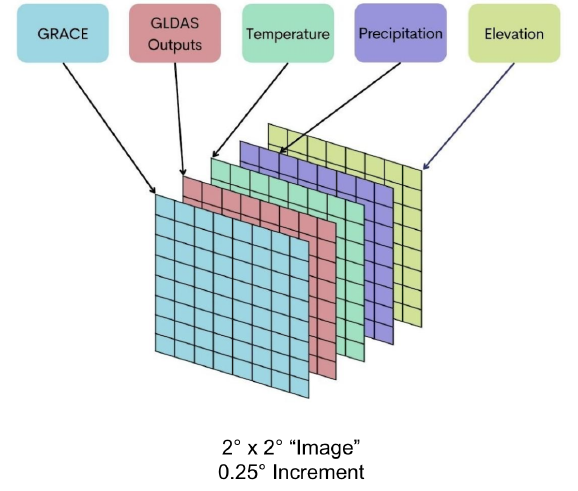
Figure 3. Satellite data “image” that is fed into the Tile2Vec model.